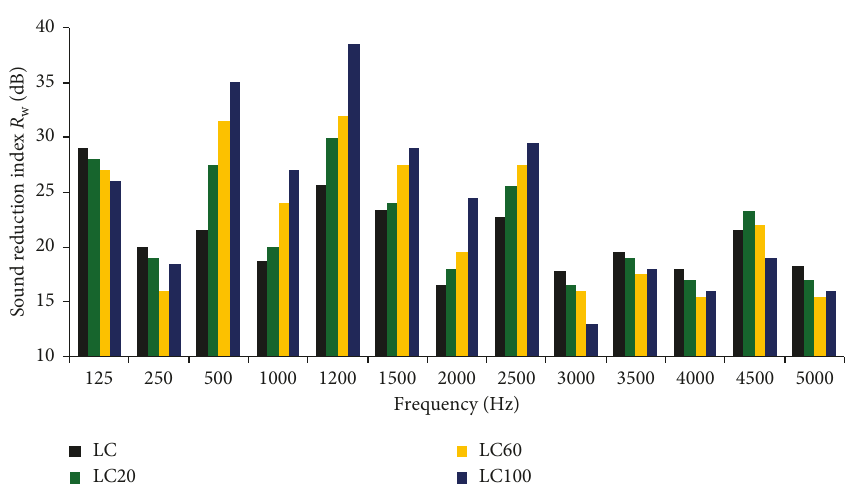
Figure 12: Effect of SWM dosage on the sound reduction index of